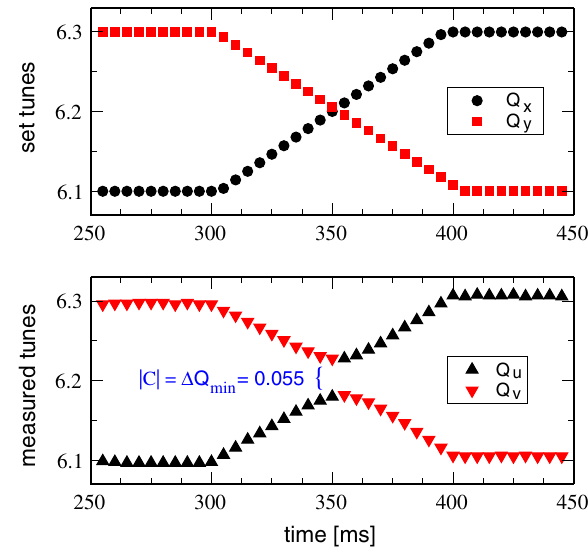
FIG. 7. Example of closest tune approach applied to the CERN PS after powering a strong skew quadrupole [95]. Top: The model betatron tunes programmed to cross the difference resonance. Bottom: Corresponding measured tune values. Δ Q is inferred from the closest approach between the tunes at the crossover